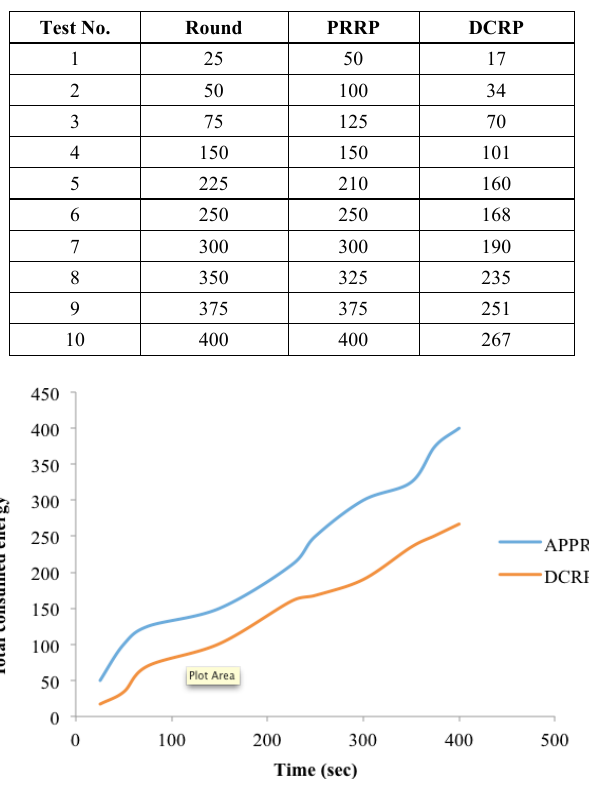
Fig. 10. Total consumed energy versus time for DCRP and PRRP protocols